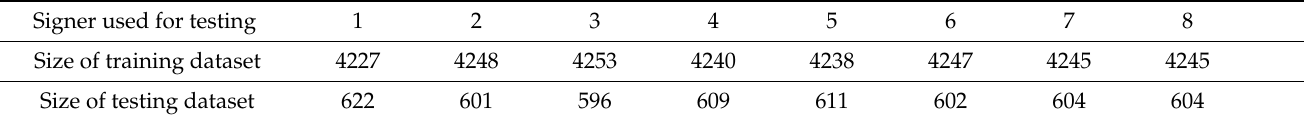
Table 2. Distribution between training and testing datasets in our